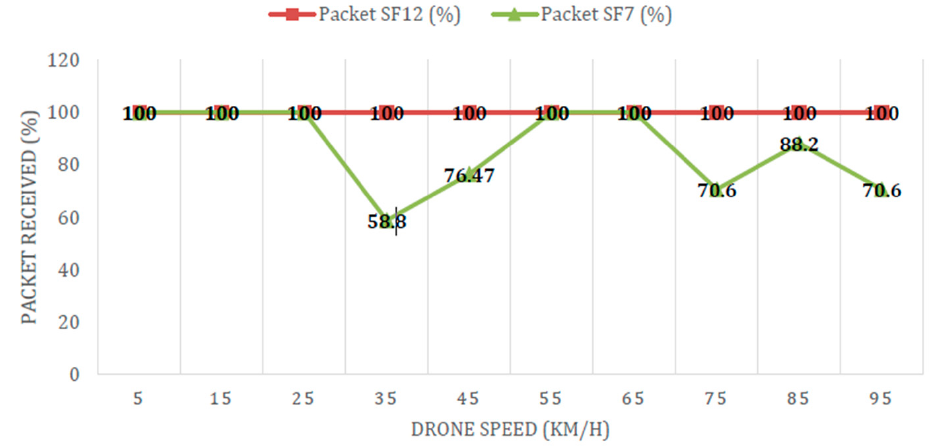
Figure 16. Performance of LoRa multi-channel gateway against different drone speeds.